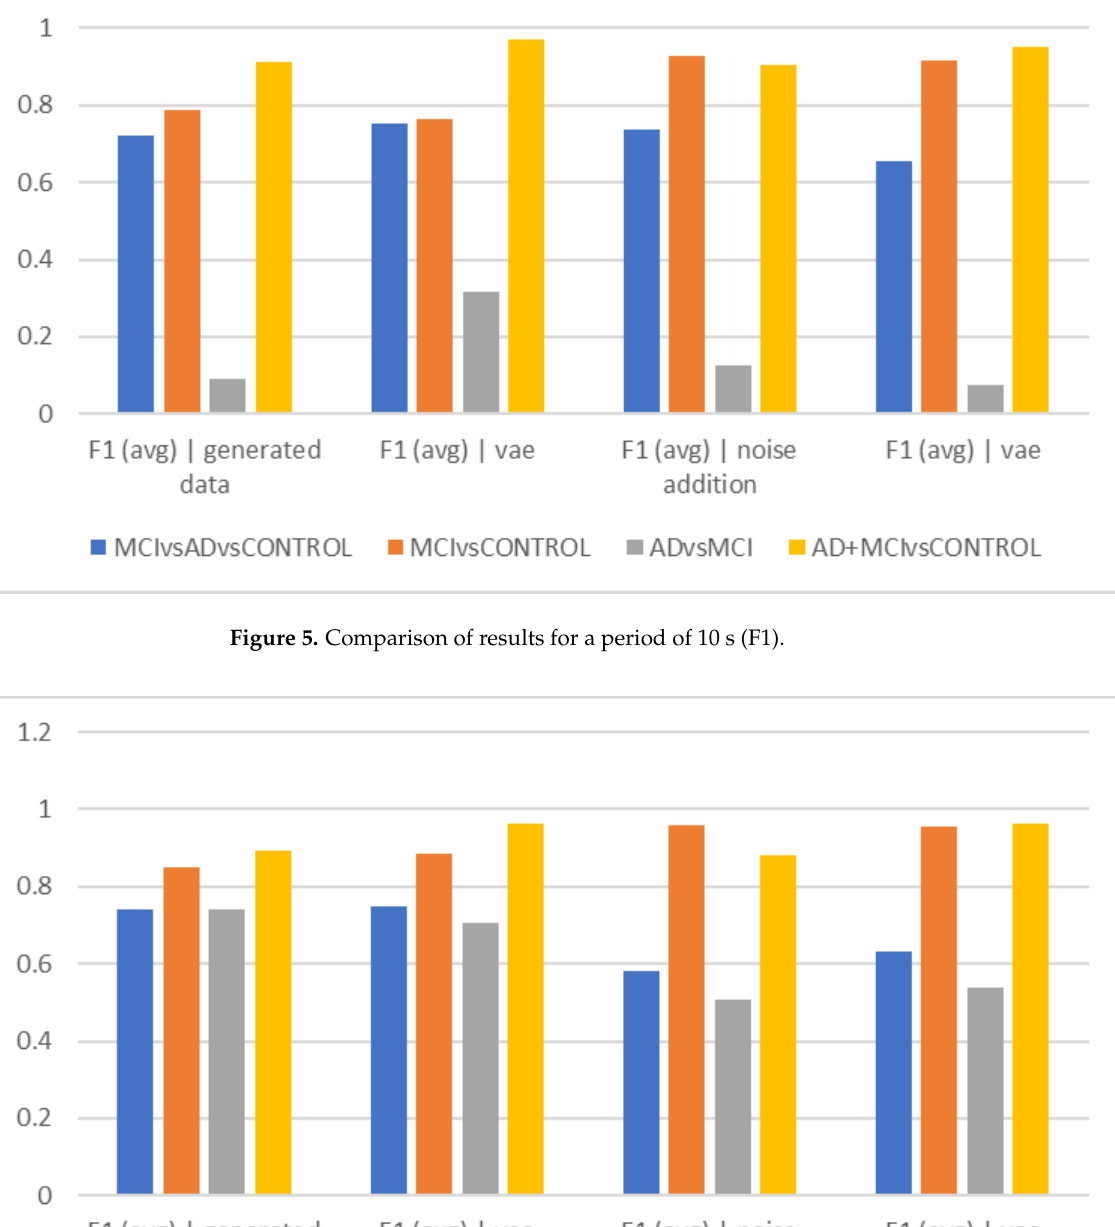
Figure 4. Comparison of results for a period of 10 s (accuracy).